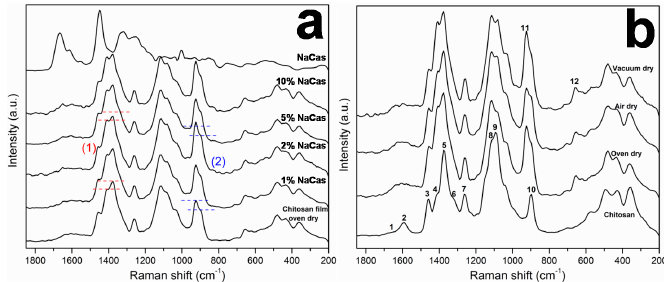
Figure 3. ( a ) Raman spectra of oven dry chitosan/caseinate films obtained after addition of different percentages of sodium caseinate (NaCas) to chitosan (HMW CHI), showing the increase of the intensity of the bands at 1410 and 1372 cm − 1 ((1) in red), and the bands at 924 and 895 cm − 1 ((2) in blue), when compared to the spectrum of the oven dry chitosan film without caseinate. The spectrum of the pure caseinate (NaCas) film is included for comparison. ( b ) Raman spectra of chitosan/acetate films obtained under different drying conditions. For comparison, the spectrum of the starting HMW CHI powder (chitosan) is also included in ( b ). The assignment of the bands regions 1, 2, 3, 4, 5, 6, 7, 8, 9, 10, 11, and 12 are discussed in detail above in the text in Section 2.2.2.